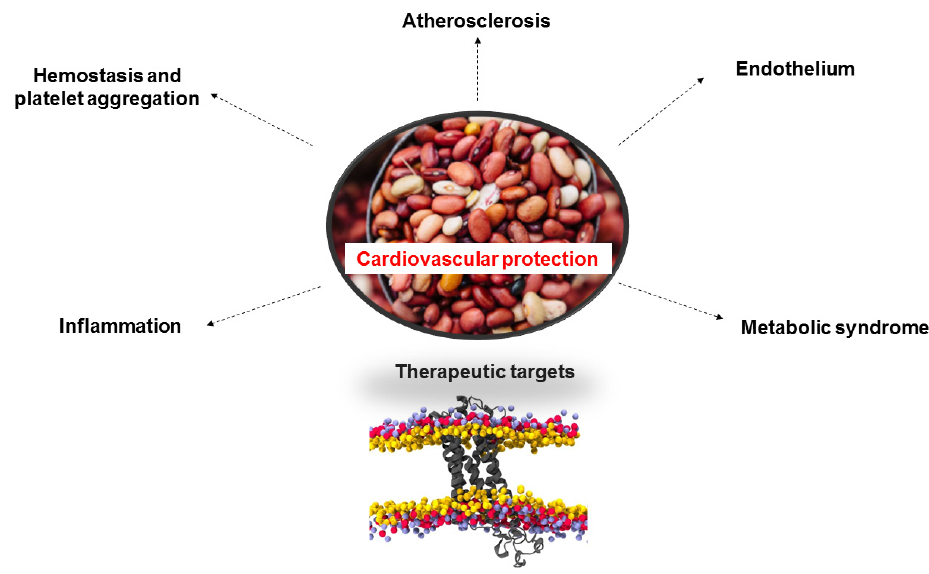
Figure 4. Cardioprotective Effects of Phaseolus vulgaris L. Source: created by the authors.